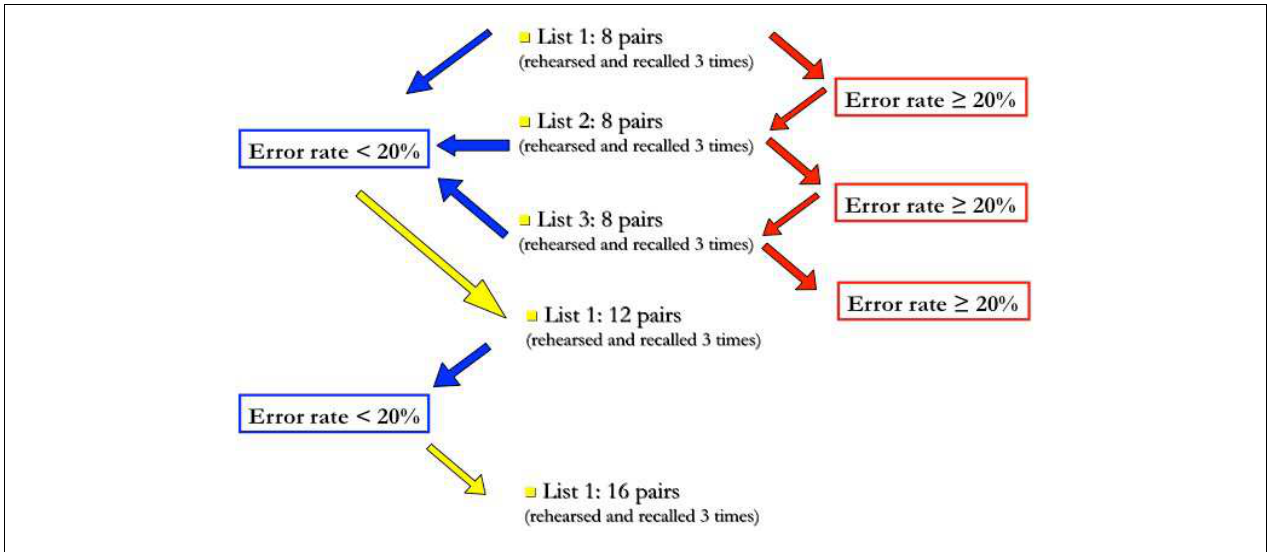
same length.The trial is terminated when the subject does not succeed in decreasing his error rate below 20% at third recall; otherwise, this same procedure is repeated with longer (12-, 16-, and 20-pairs)